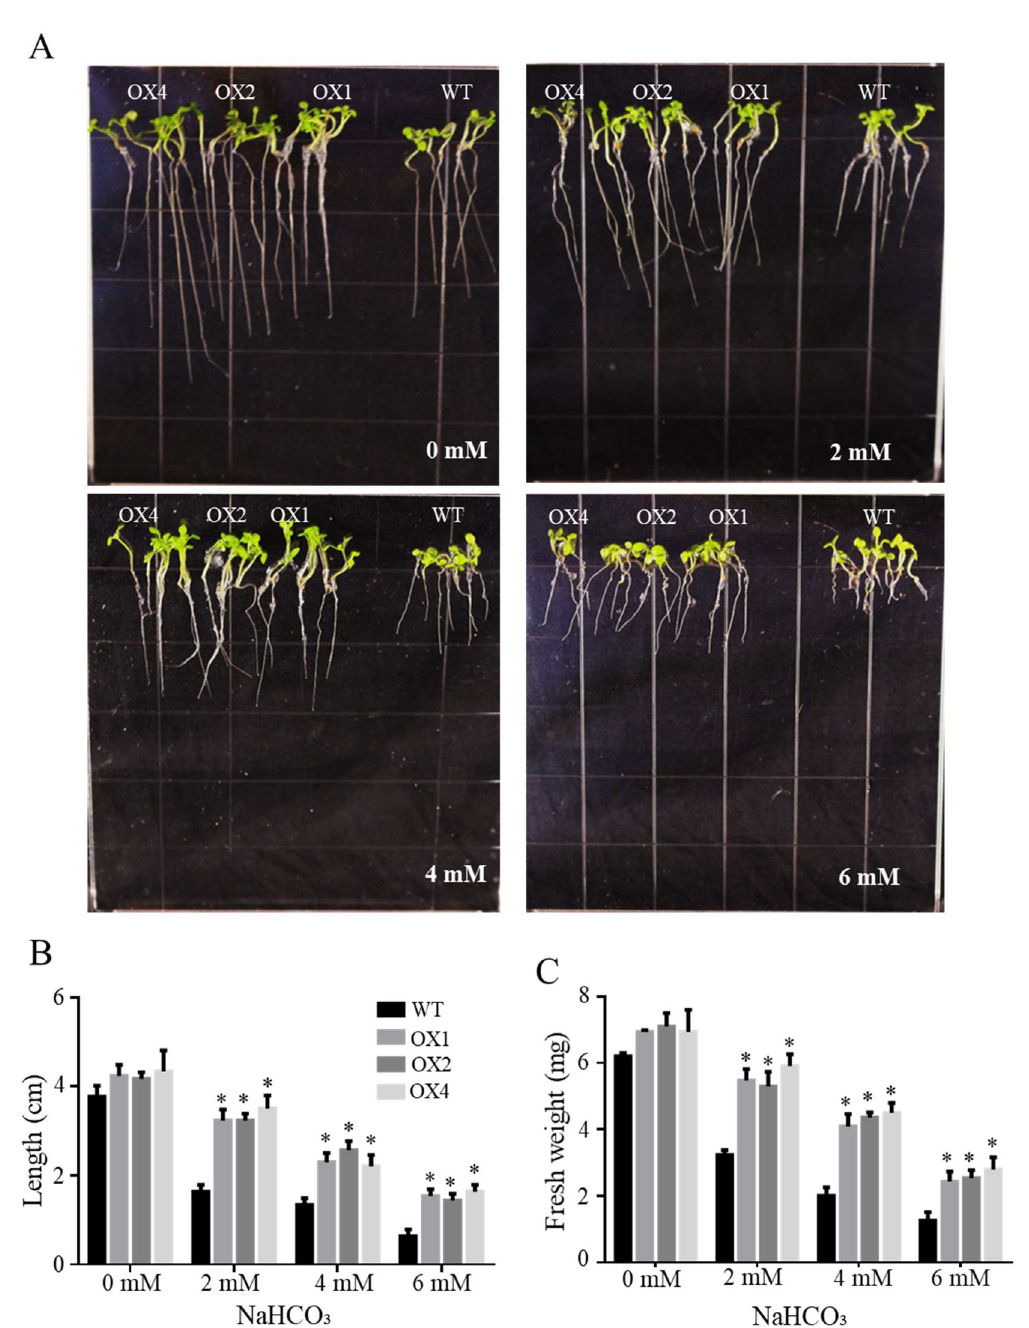
Figure 5. Effects of NaHCO 3 stress on the growth of wild-type (WT) and ChbZIP1-overexpressed transgenic Arabidopsis plants. ( A ) Phenotypes of ChbZIP1 transgenic and WT lines subjected to 0, 2, 4, and 6 mM NaHCO 3 treatment, respectively. ( B ) Root length changes in ChbZIP1 transgenic and WT lines. ( C ) Fresh weight changes in ChbZIP1 transgenic and WT lines. * indicates p -value < 0.05.